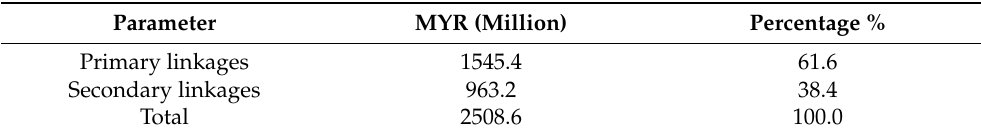
Table 4. Estimated Total Development